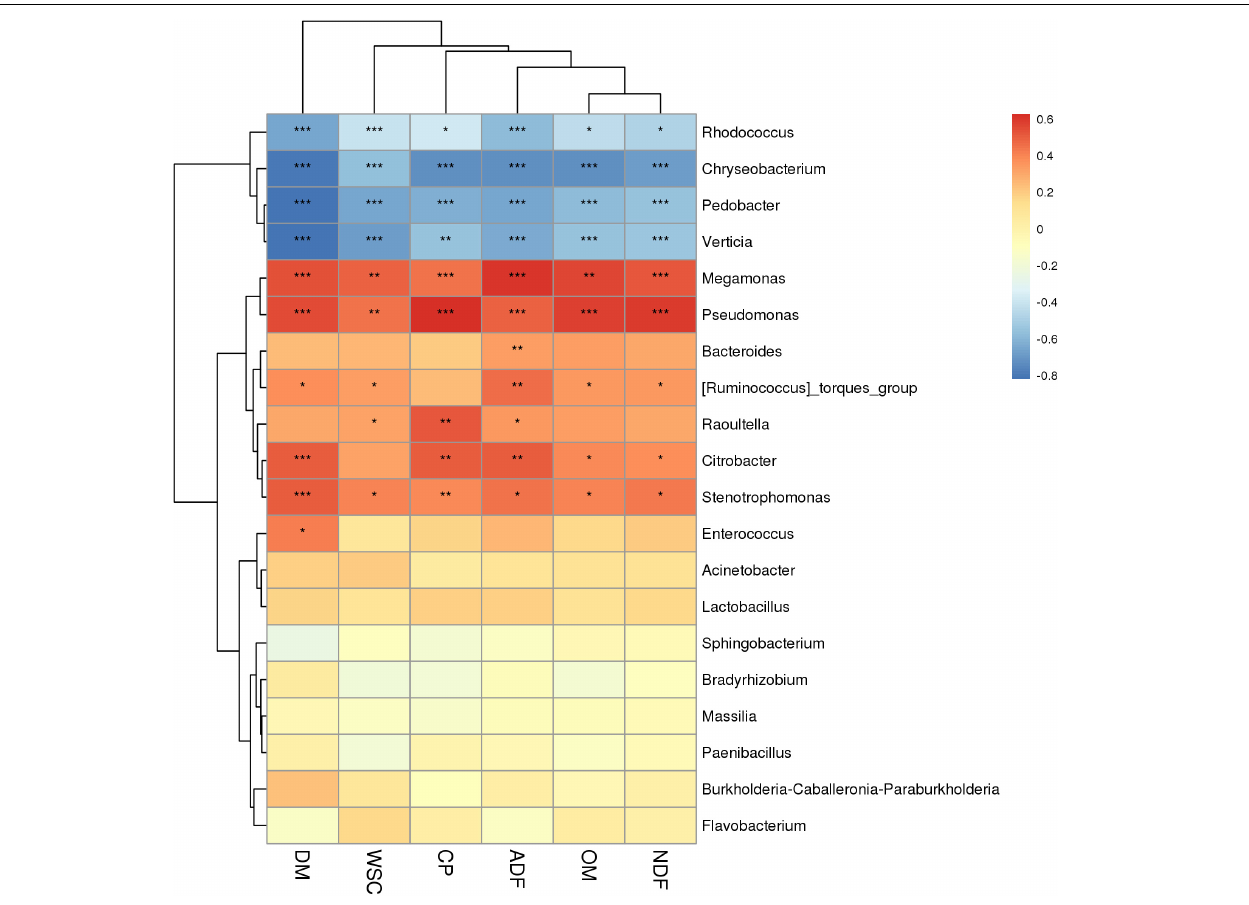
FIGURE 3 | Correlation analysis of the bacterial community with chemical composition of P. sinese silage at genus level. The blue indicates a negative correlation, red indicates a positive correlation. “*,” “**,” and “***” represent P < 0.05, P < 0.01, and P < 0.001,